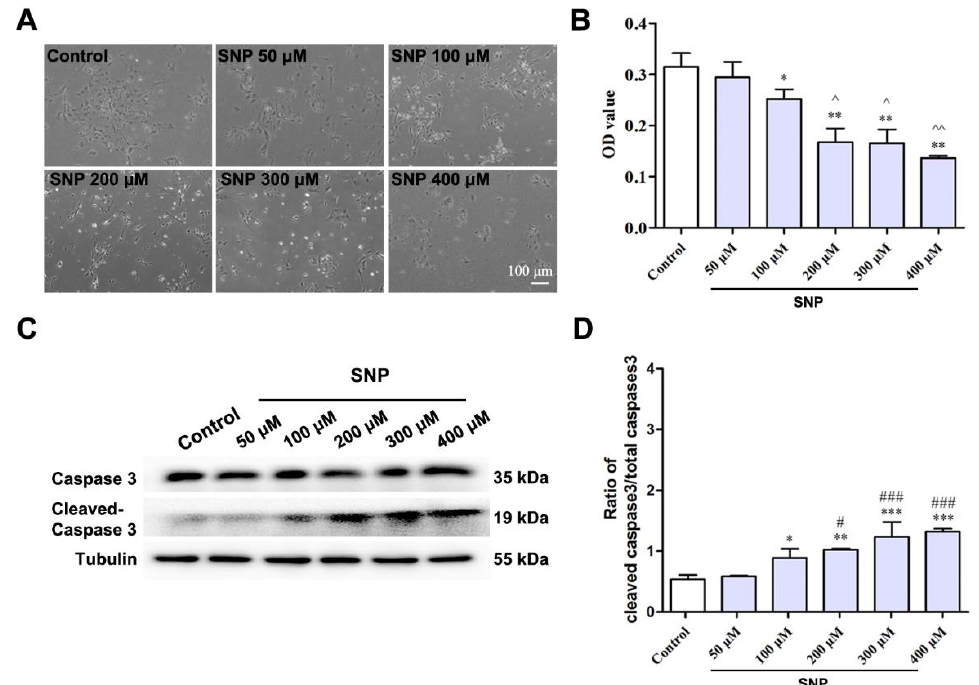
Figure 2. The effects of SNP on the survival of differentiated NSCs. ( A ) The survival and morpho- logical changes of differentiated NSCs after SNP treatment. Scale bar = 100 µ m. ( B ) Cell survival of differentiated NSCs after SNP treatment. ( C ) Expressions of caspase 3 and cleaved caspase 3 in differentiated NSCs. ( D ) Data analysis of the ratio of cleaved caspase 3/total caspase 3. The values of the ratio of cleaved caspase 3/total caspase 3 in SNP-treated groups were normalized by the control. All data were obtained from three independent experiments and more than three replicates for every experiment. The values are the mean ± SD and were analyzed via a one-way ANOVA test. Compared with control * p < 0.05, ** p < 0.01, *** p < 0.001; compared with the SNP 50 μM group # p < 0.05, ### p < 0.001; compared with the SNP 100 μM group ^ p < 0.05, ^^ p < 0.01; compared with the SNP 200 μM group; compared with the SNP 300 μM group , n = 5.